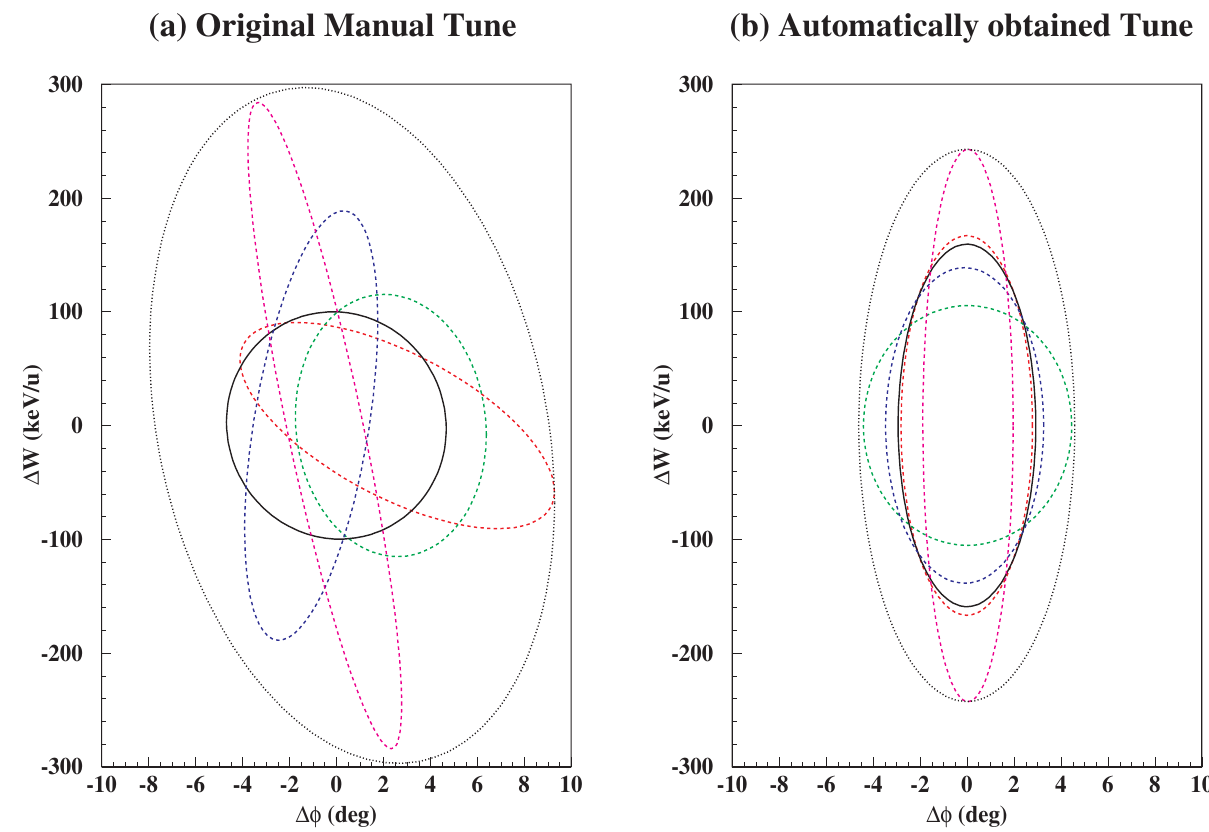
FIG. 6. (Color) Beam ellipses just before the second stripper for both (a) the original manual tune and (b) the automatically obtained tune. The solid ellipse corresponds to the reference charge state, the dashed ones are for other charge states and the larger dotted ellipse represents the effective emittance of the multiple-charge-state beam.